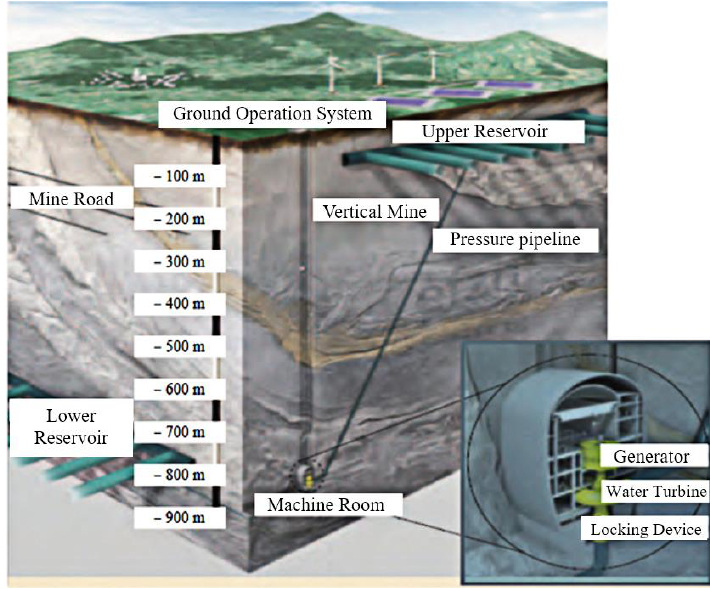
Figure 2. Underground roadway + underground roadway.